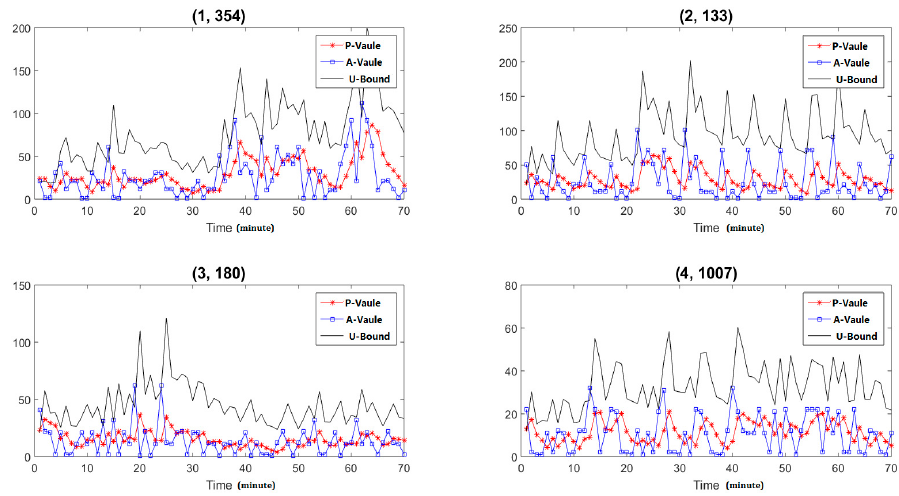
Figure 7. Results of different end nodes.